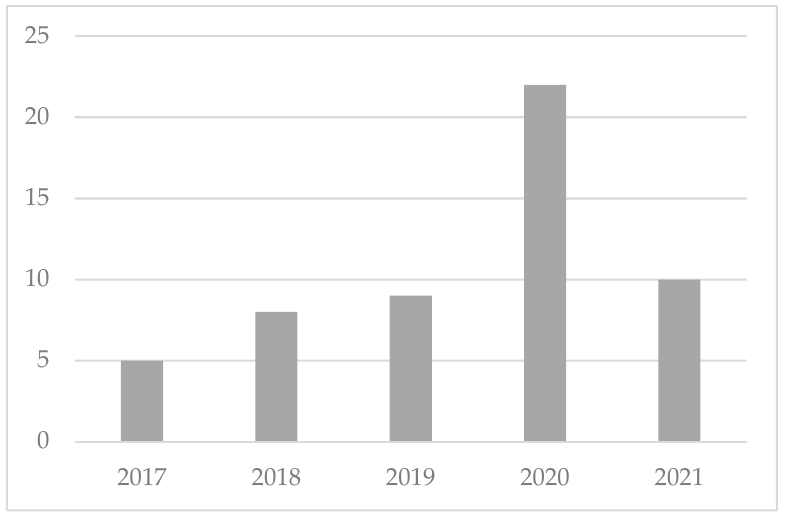
Figure 3. Distribution of the resulting articles by year.